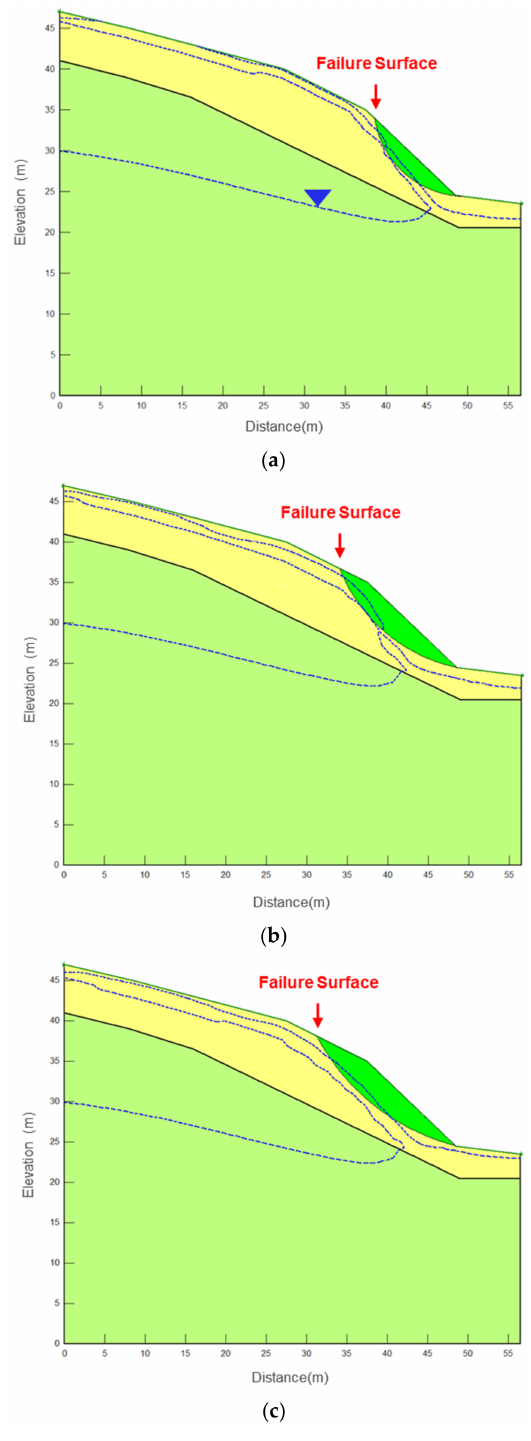
Figure 9. The failure surface under different rainfall conditions (Da-Dong-Shan rainfall station): ( a ) 2016; ( b ) 2050; ( c )